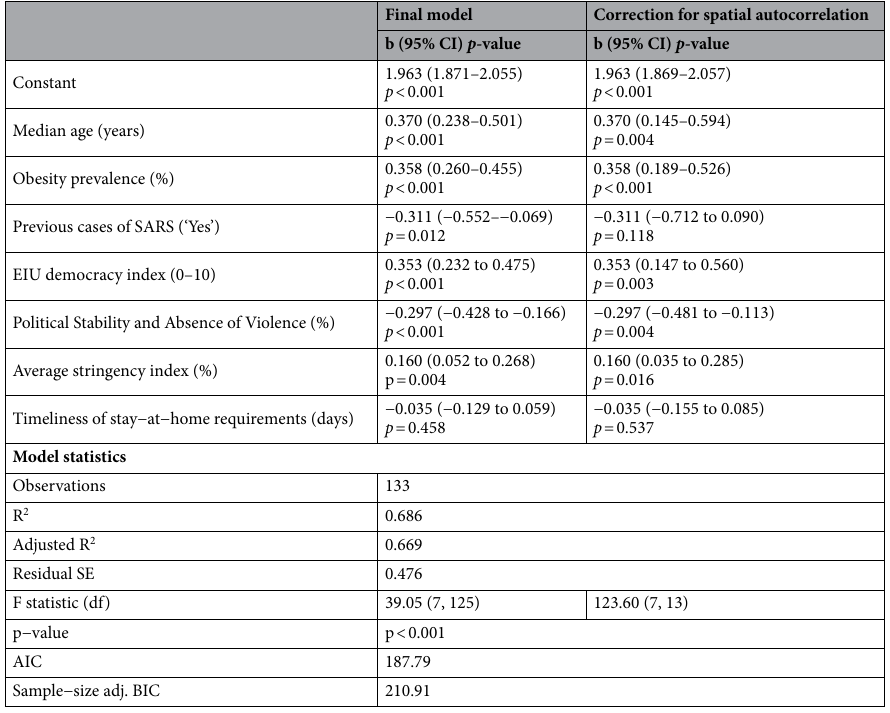
Table 2. Final multivariate model for global COVID-19 mortality adjusted for response measures. In the final model, three observation (ie, Mongolia, Thailand, and Papua New Guinea) was removed because outlier, as described in the supplementary results. Regions are controlled as sampling clusters and the clustering effect was accounted for using cluster-robust standard errors (the clustered sandwich estimator) . EIU Economist intelligence unit; SARS Severe acute respiratory syndrome.